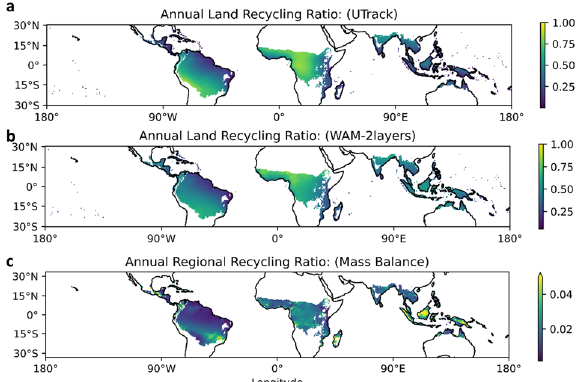
Fig. 1 Mean annual recycling ratios. The mean annual recycling ratio is visualized from 2002 to 2018 for UTrack ( a ), WAM-2layers ( b ), and Mass Balance ( c ) within the tropical Köppen – Geiger climate zones. Identical color scales are used for each plot, but the range of the Mass Balance color gradient is reduced from 0 – 1 to 0 – 0.05 due to the generally smaller values taken on by the regional recycling ratio (RRR) in comparison to the land recycling ratios